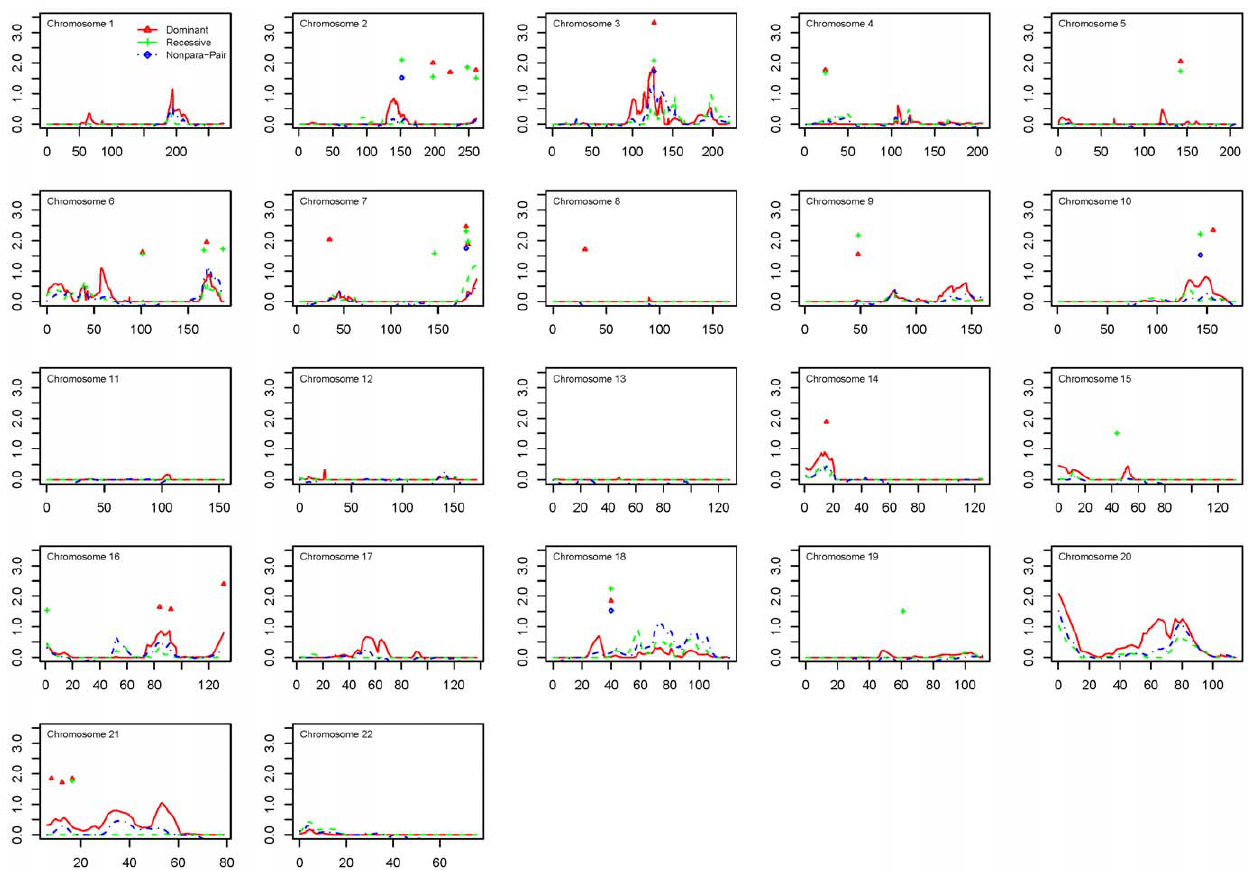
Figure 3. Linkage results for the African ancestry dataset. Multipoint linkage scores for parametric dominant (red), parametric recessive (green), and nonparametric (blue) models are plotted for the African ancestry dataset. Symbols indicate two-point lod scores $ 1.5 in the parametric dominant (red) and recessive (green) models.